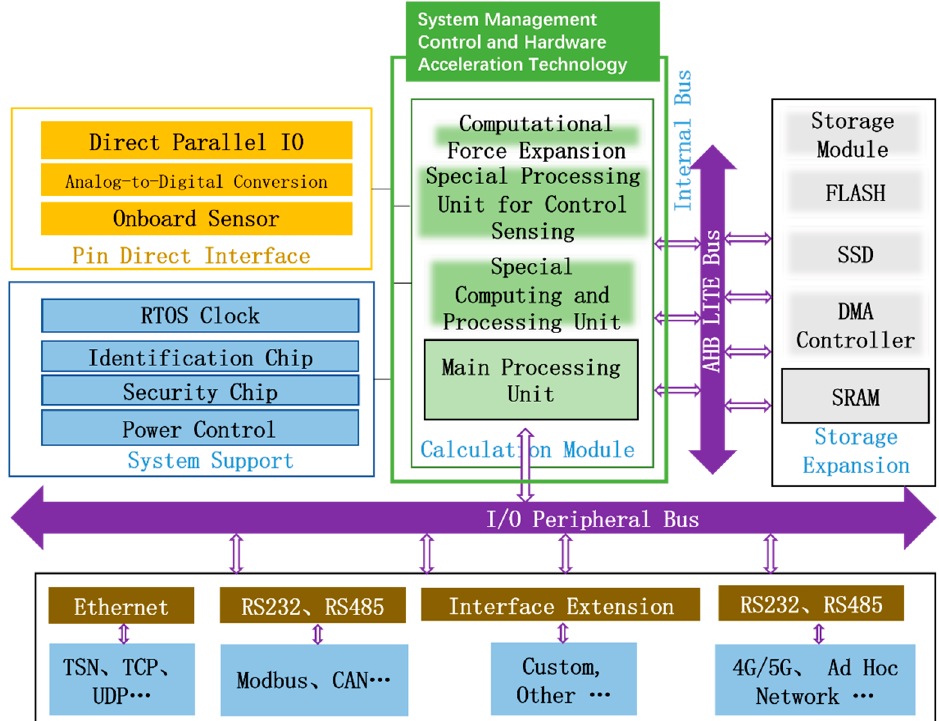
Figure 1. The hardware block diagram of the controller based on an autonomous processor.